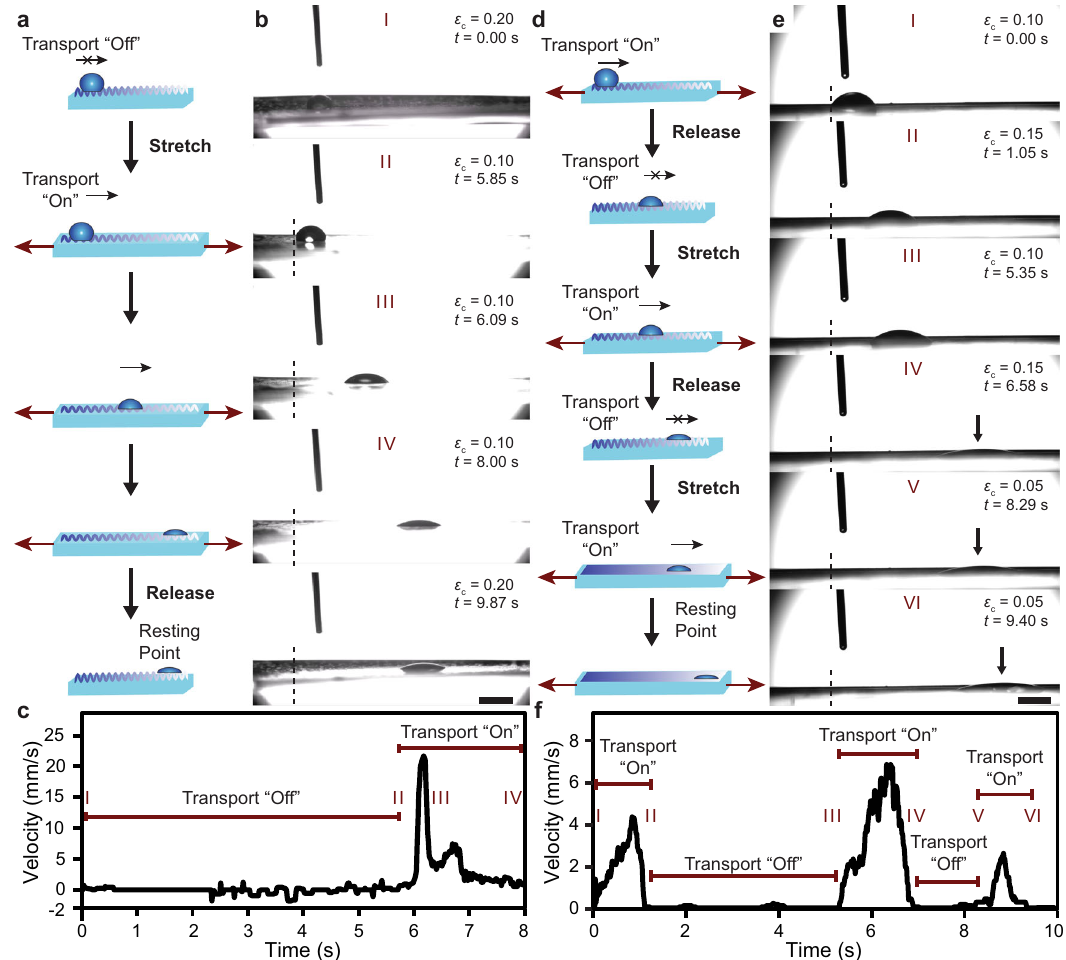
Fig. 3 Controlling droplet transport dynamically using mechanical deformations. a General schematic and b optical micrographs illustrating the dynamic transition of fl uid transport from an “ off ” state to an “ on ” state using mechanical strain (compressive strain, ε c and time, t , are given). c Temporal velocity pro fi le of the microdroplet extracted from the control sequence in b . d Schematic and e optical micrographs illustrating the dynamic toggling of fl uid transport between “ on ” and “ off ” states using mechanical strain. f Temporal velocity pro fi le of the microdroplet extracted from the control sequence in e . Scale bars = 2